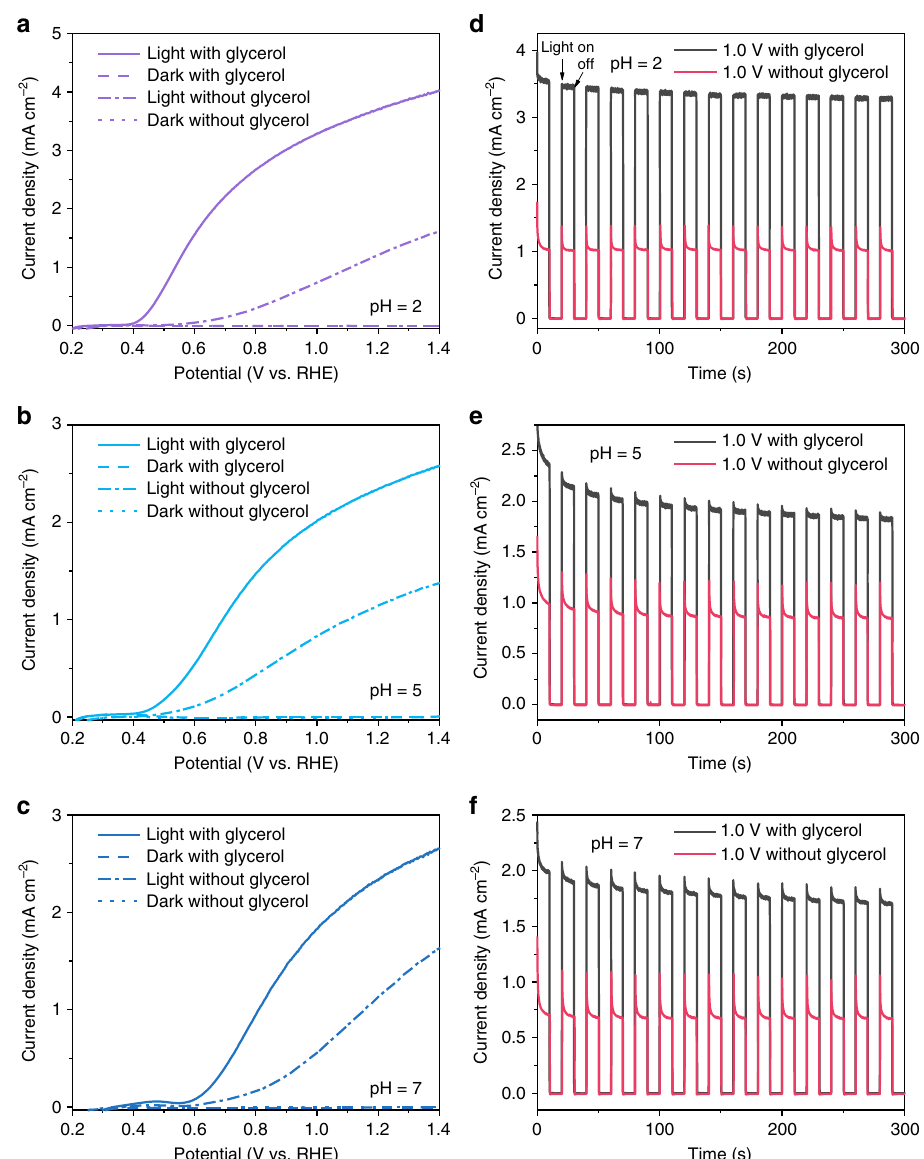
Fig. 1 Photoelectrochemical performances. a – c Current density-potential pro fi les of BiVO 4 photoanode measured in 0.5 M Na 2 SO 4 at various pH in an H- type cell under dark and AM 1.5 G, 100 mW cm − 2 illumination. d – f Chopped photocurrent density-time pro fi les of BiVO 4 photoanode at 1.0 V vs. RHE in 0.5 M Na 2 SO 4 at various pH with and without glycerol. Source data are provided as a Source Data fi of glycerol signi fi cantly increases the IPCE across the entire light absorption region of BiVO 4 , reaching 80% at 400 nm and 1.23 V vs. RHE, which is consistent with the change in photocurrent (Fig. 3d) as a result of impaired binding of glycerol on BiVO 4 as discussed previously.